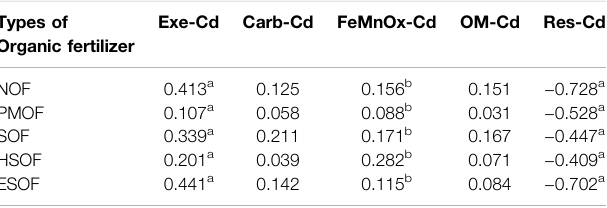
TABLE 3 | Analysis of the relationship between bioavailable Cd and Cd chemical speciation.